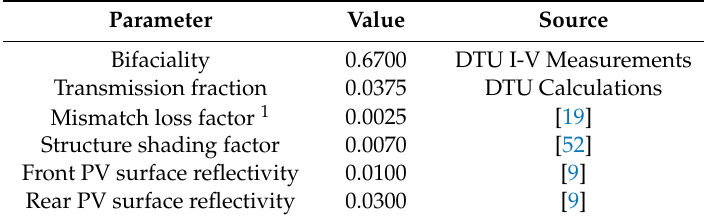
Table A4. Bifacial-specific coe ffi cients used in the simulations.